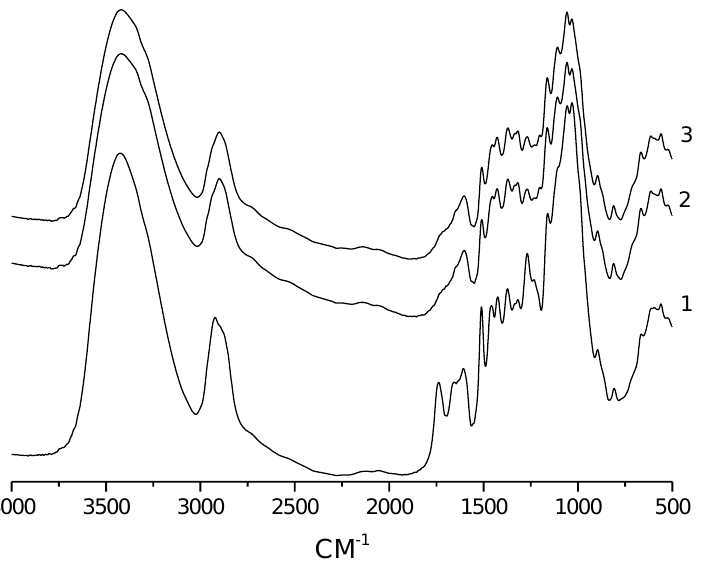
Figure 14. IR spectra for the initial spruce wood samples (1) and the solid products of wood RCF over the 3RS450 (2) and 3RS400 (3)